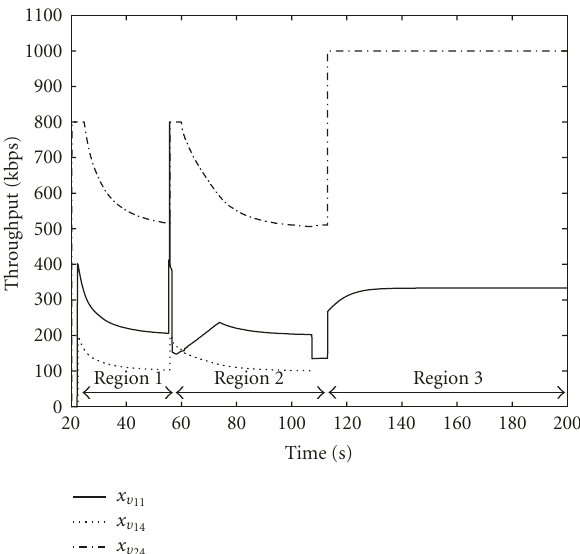
= 4, g = 1, g = υ 14 υ 24 11